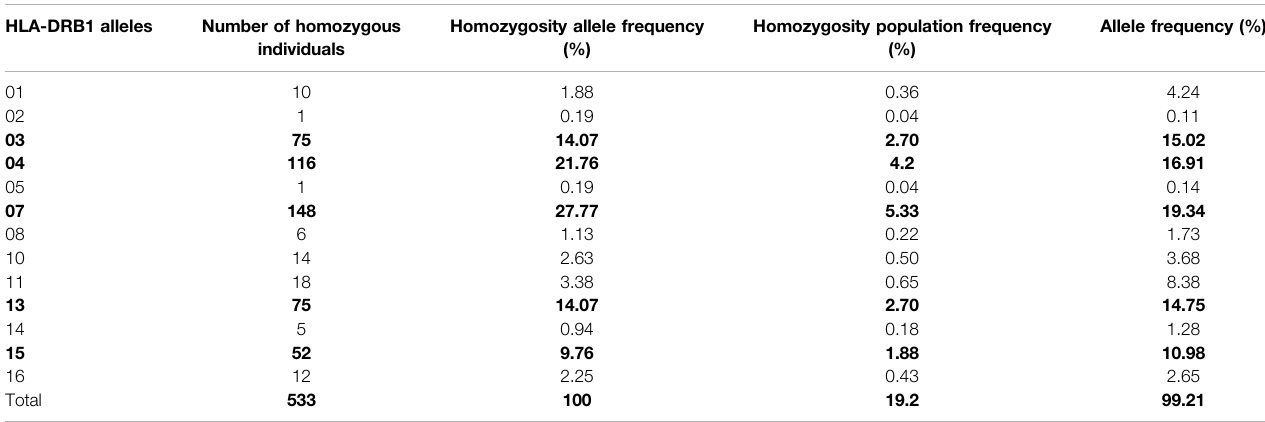
Bold values indicate the highest